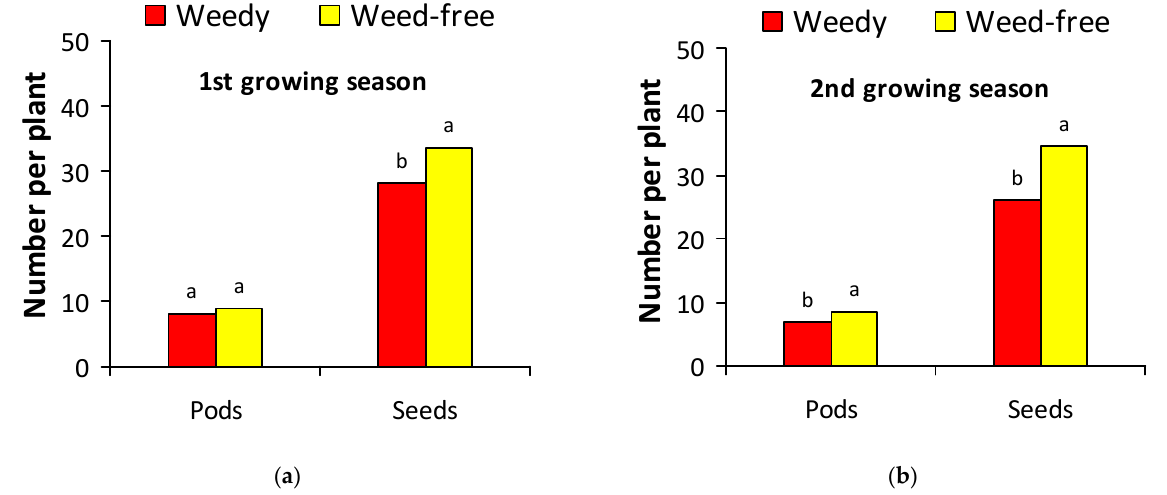
Figure 2. Number of white lupine pods and seeds per plant in weedy and weed ‐ free treatments ( a ) in the first growing season; ( b ) in the second growing season. Different letters in each variable indicate statistically significant differences at p < 0.05.